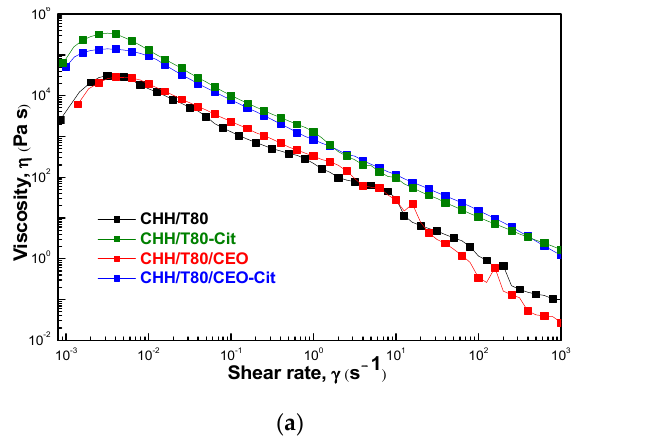
13 of 21 Figure 7. 1 H-NMR spectra of eugenol (Eu) and of Tween 80 (T80) ultrasonicated (Us) in acetic acid individually or together ( a ) and of the obtained CHH and CHH/T80/CEO hydrogels ( b ). 1 H-NMR spectra were also recorded for the powdered unloaded chitosan sample solubilized in D 2 O/DCl (CHH sample) and for the chitosan–clove oil hydrogel finely dispersed in D 2 O/CD 3 COOD (CHH/T80/CEO sample). Besides the peaks of chitosan, the 1 H-NMR spectra of the CHH/T80/CEO hydrogel (Figure 7b) had additional small peaks at 6.7–6.9 ppm, 6 ppm, 3.3 ppm, and a shoulder at 3.9 ppm, which correspond to the ar- omatic, unsaturated, saturated allyl and methoxy protons in the structure of eugenol, re- spectively. This is additional proof for the strong fixation of compounds from clove es- sential oil in the structure of the hydrogel. 3.2.3. Rheological Properties The dynamic viscosity was represented as a function of the shear rate for all studied hydrogels (Figure 8a). These manifested a non-Newtonian, pseudoplastic behavior. A slight shear thickening effect was observed for all samples at very low shear rates below ~2.5–6.0 10 − 3 s − 1 . This was followed by constant fall in the viscosity with the increasing shear rate, indicating gel-like structures. A sudden fall of viscosity with an increase in shear rate above ~ 10 s − 1 for unloaded and CEO-loaded chitosan hydrogels suggests the apparition of viscous heating, which decreases the viscosity due to the heating effect caused by dissipated energy through shear. Citrate crosslinking increased the dynamic viscosity, and this was mainly due to rigidization since the viscous heating appeared at